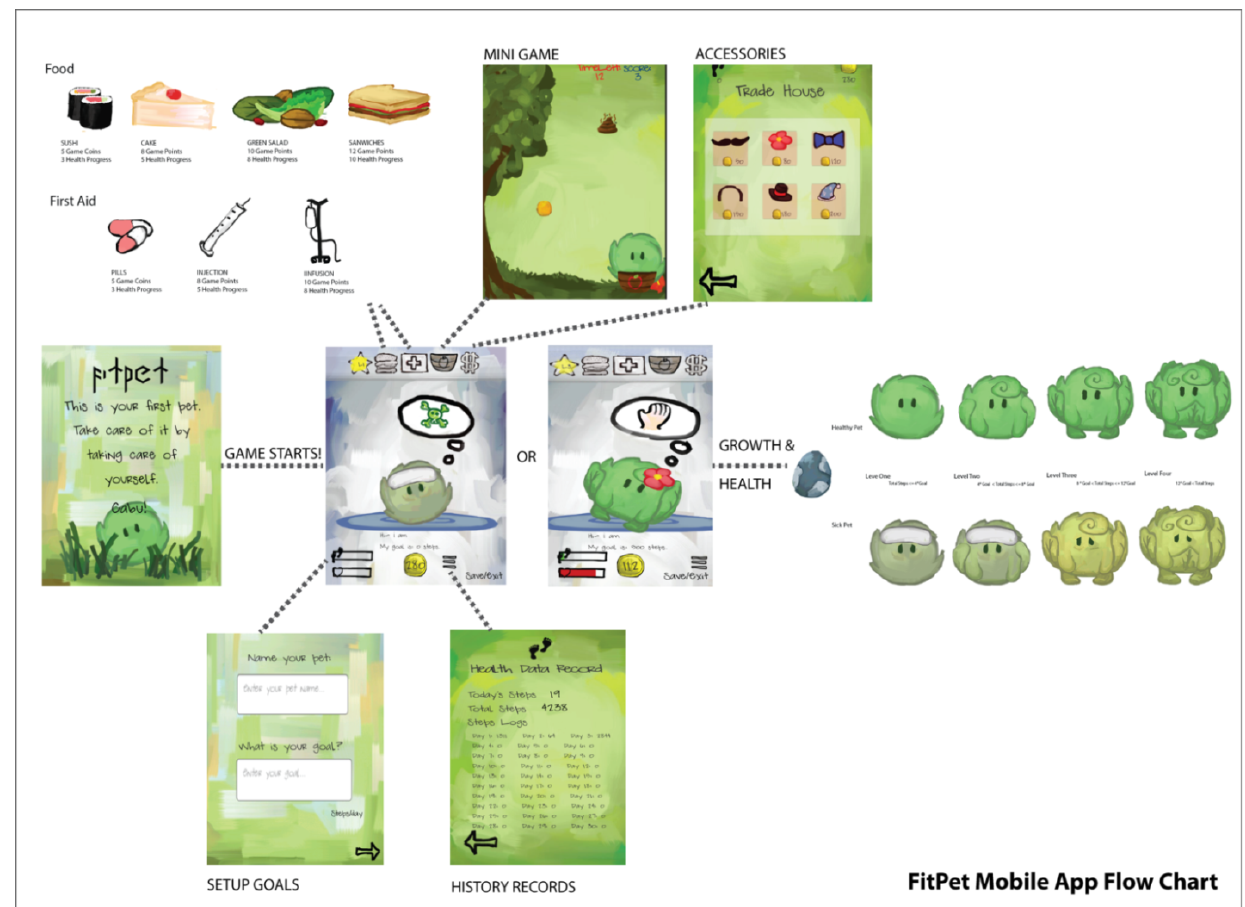
Figure 2 . The Flow Chart of FitPet Mobile